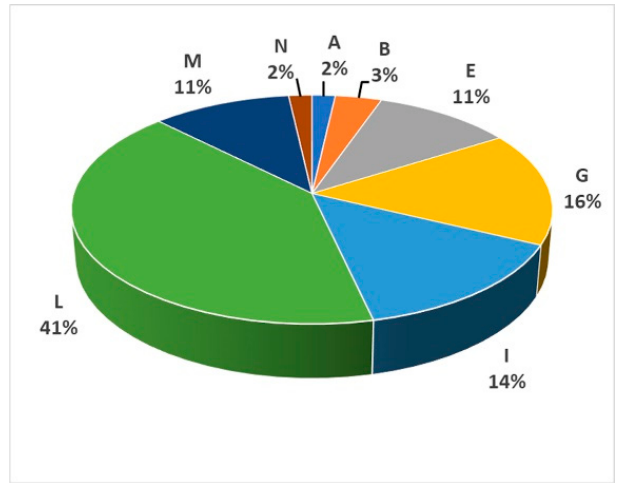
Figure 3. MtDNA haplogroup frequency distribution in the SAA.